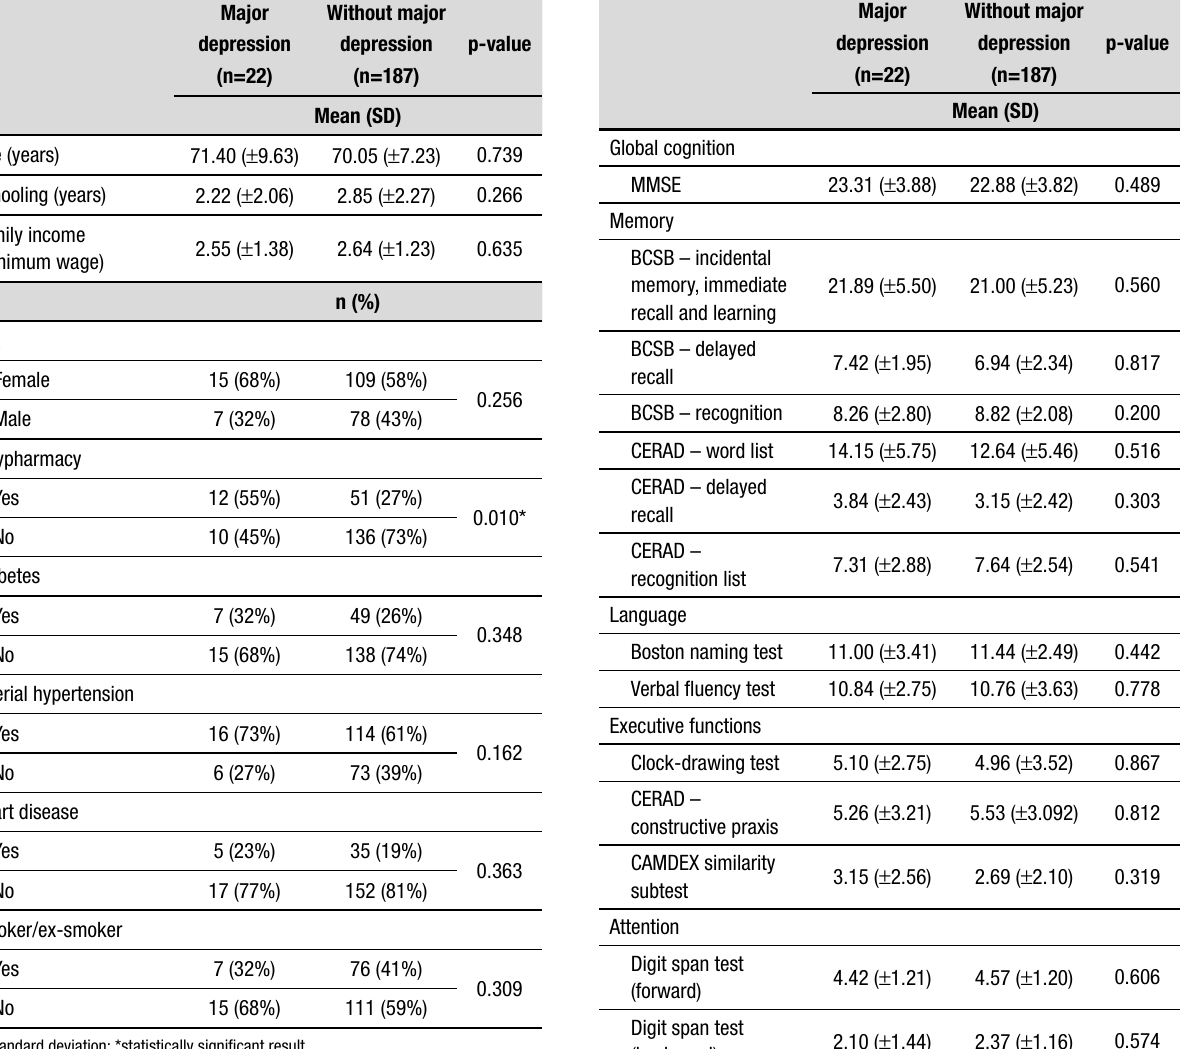
Table 1. Clinical and demographic characteristics of the groups with and without depression.